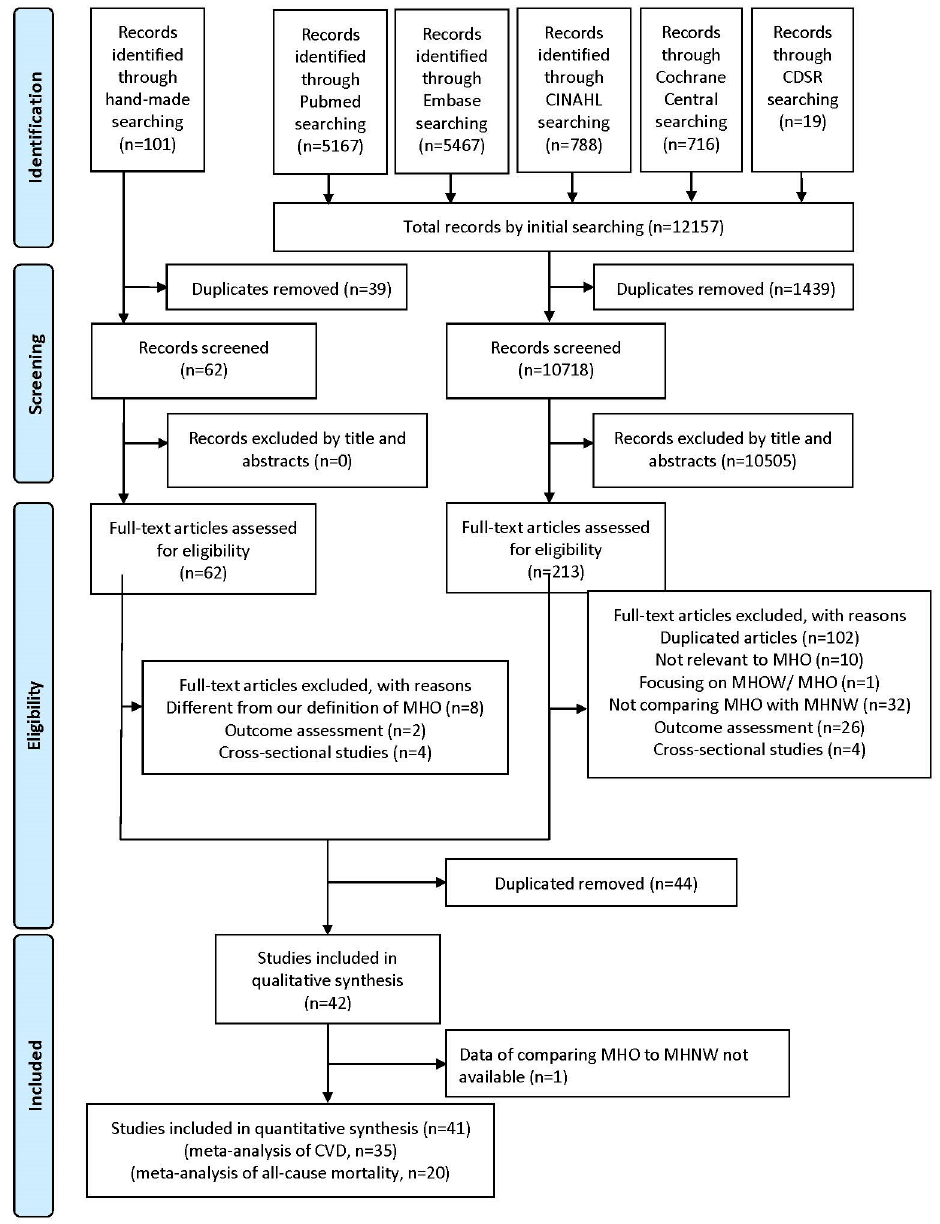
Figure 1. Flowchart of the study selection process.